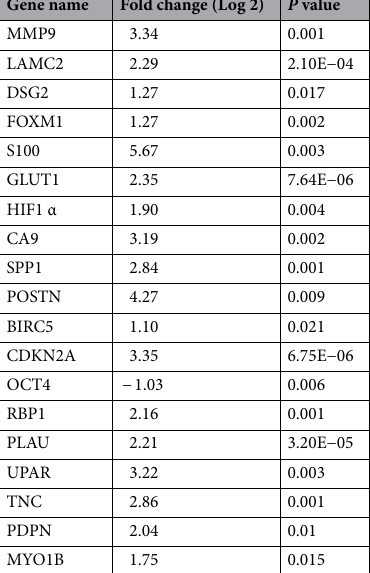
Table 2. Differentially expressed genes associated with OTSCC assessed by